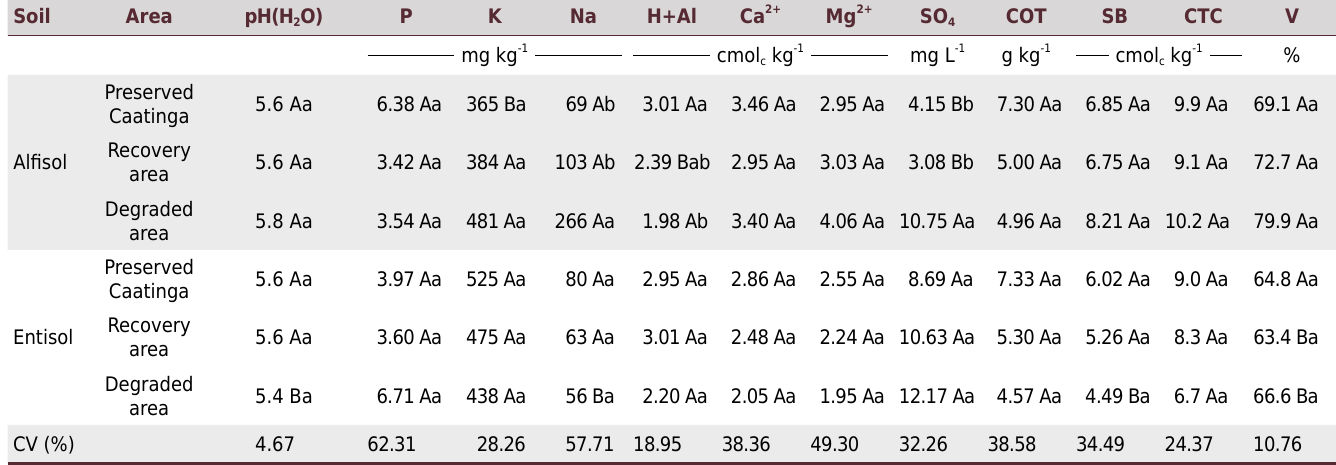
Table 2. Mean values of chemical properties of the Alfisol and Entisol from the Preserved Caatinga (strata: catingueira, jurema, marmeleiro, and between trees), Recovery Area with jurema (strata: jurema and between trees), and Degraded Area without plant cover, at a layer of 0.00-0.10 m, in the dry period